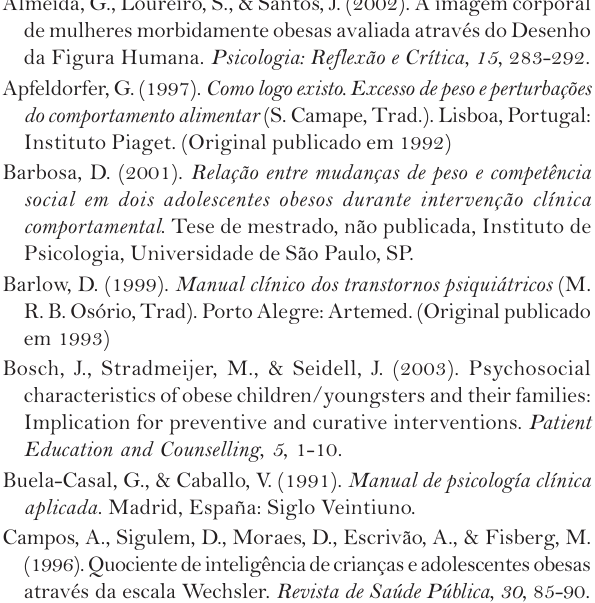
Almeida, G., Loureiro, S., & Santos, J. (2002). A imagem corporal de mulheres morbidamente obesas avaliada através do Desenho da Figura Humana. Psicologia: Reflexão e Crítica , 15 , 283-292. Apfeldorfer, G. (1997). Como logo existo. Excesso de peso e perturbações do comportamento alimentar (S. Camape, Trad.). Lisboa, Portugal: Instituto Piaget. (Original publicado em 1992) Barbosa, D. (2001). Relação entre mudanças de peso e